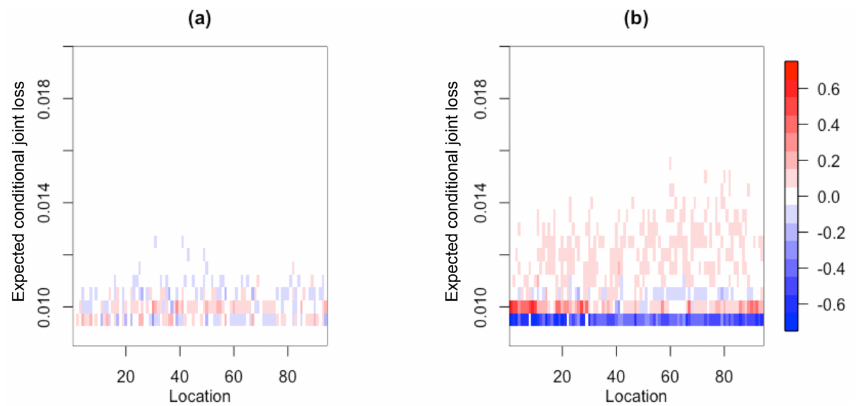
Figure 10. For a stratified sample of 100 locations within the windstorm footprint domain, the difference between modelled and empirical relative frequencies of binned ranges of expected conditional joint loss for (a) the Gaussian model and (b) the Gumbel